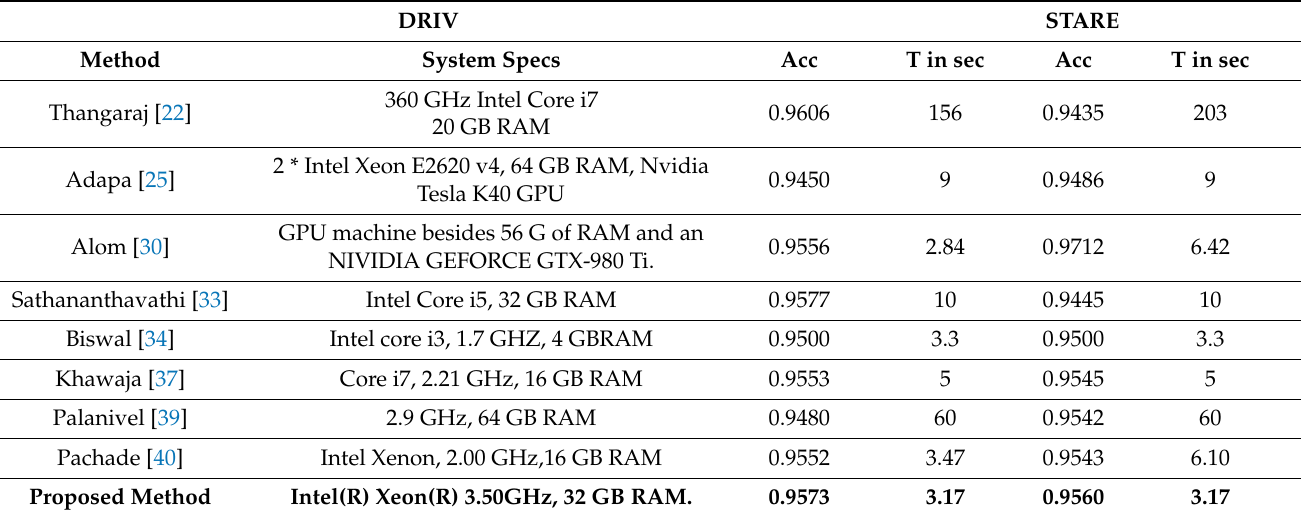
Table 5. Execution time